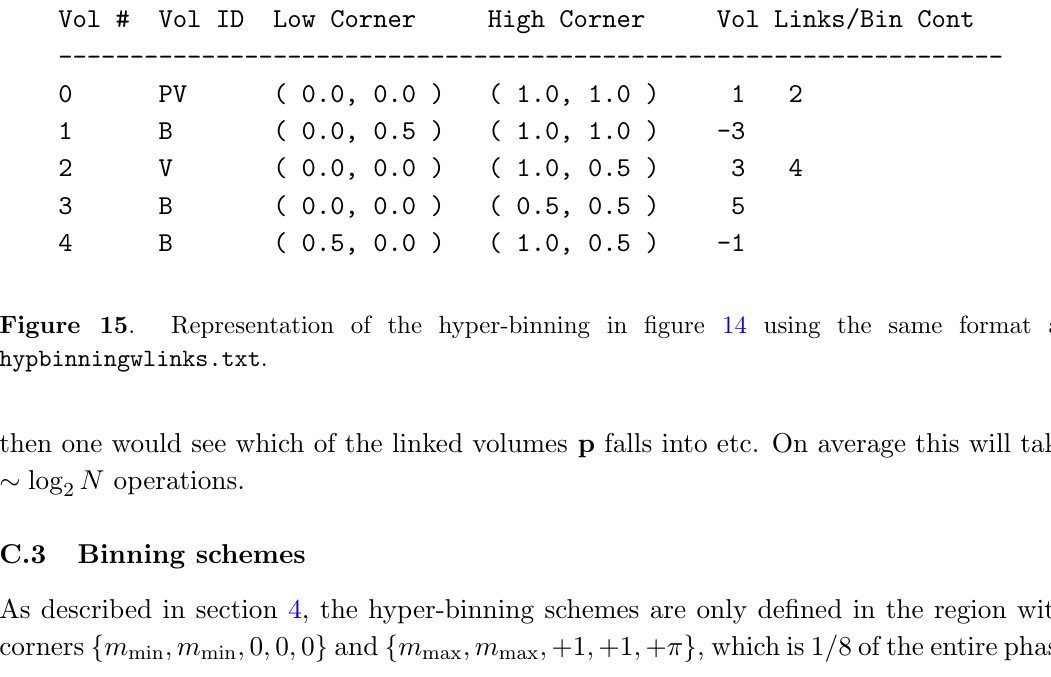
Figure 14 . Simple example that demonstrates how the hyper-binning algorithm works. At iteration 0 there is a single primary volume (PV) with volume number 0. At iteration 1, the primary volume is split into two volumes with volume numbers 1 and 2. Volume number 1 is not split any further, so it is labelled as a ‘bin’ (B) rather than a ‘volume’ (V) | the content of this bin is -3. In iteration 2, volume number 2 is further divided into volume numbers 3 and 4; since this is the (cid:12)nal iteration, these volumes are labelled as bins, which have bin contents of 5 and -1 respectively.